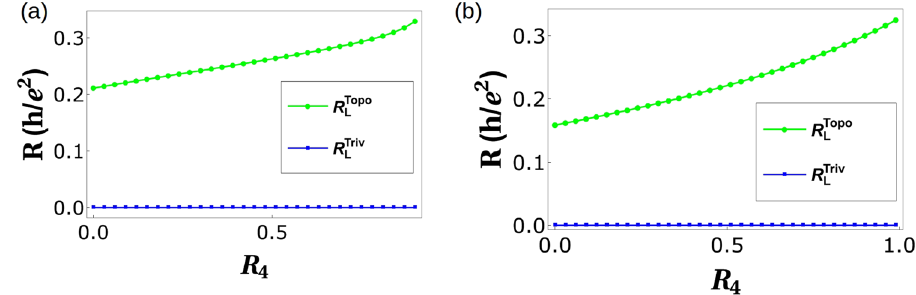
Figure 8. ( a ) Longitudinal resistance R L vs. Disorder R 4 for parameters R 1 = 0.5 and spin-flip probability f = f 0 = 0.5, ( b ) Longitudinal resistance vs. Disorder R 4 in presence of inelastic scattering for parameters R 1 = 0.5 and spin-flip probability f = f 0 = 0.5. Note the longitudinal resistance vanishes for the trivial case but not for the topological